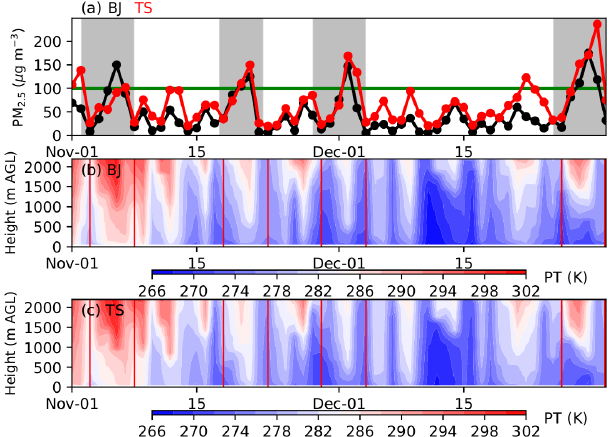
Figure 2. Time series of observed PM 2 . 5 concentration from 1 November to 31 December in 2017 in (a) Beijing and Tang- shan. (b, c) Vertical structure of potential temperature (PT) derived from the sounding data at 20:00BJT. Four heavy pollution episodes with maximum daily PM 2 . 5 concentrations greater than 100µgm − 3 in both Beijing and Tangshan are marked by the grey shading in Fig.